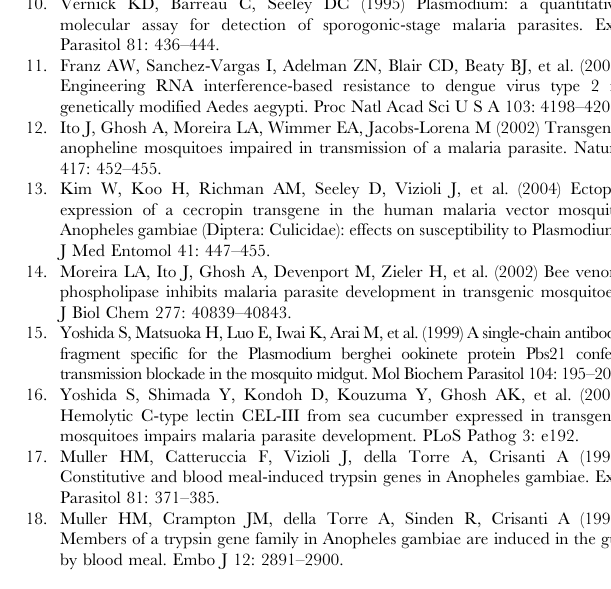
Table S2 Generation of transformants using pPB- G12EGFP. The 55 surviving adults from a total of 391 injected embryos were outcrossed with wild type A. stephensi in 4 groups of same-sex individuals. The 31 females from the female group were allowed to lay eggs in isolation (F1-F31) to determine the number of single founders. Segregation patterns of the transgene in subsequent outcrossing experiments revealed that many lines contained multiple transgene insertions at separate loci. Where possible lines were bred to achieve homozygosity at the transgenic loci. Table S3 Quantitative real time PCR analysis of EGFP reporter expression driven by the G12 promoter in A. stephensi . Quantification was performed using TaqManTM primers and probes (ABI) specific for the EGFP gene and the S7 ribosomal gene as a reference control, as previously described [1]. The PCR cycle number (Ct) at which a threshold of amplification was calculated for each gene and the level of EGFP was calculated relative to the S7 internal control using the delta Ct method